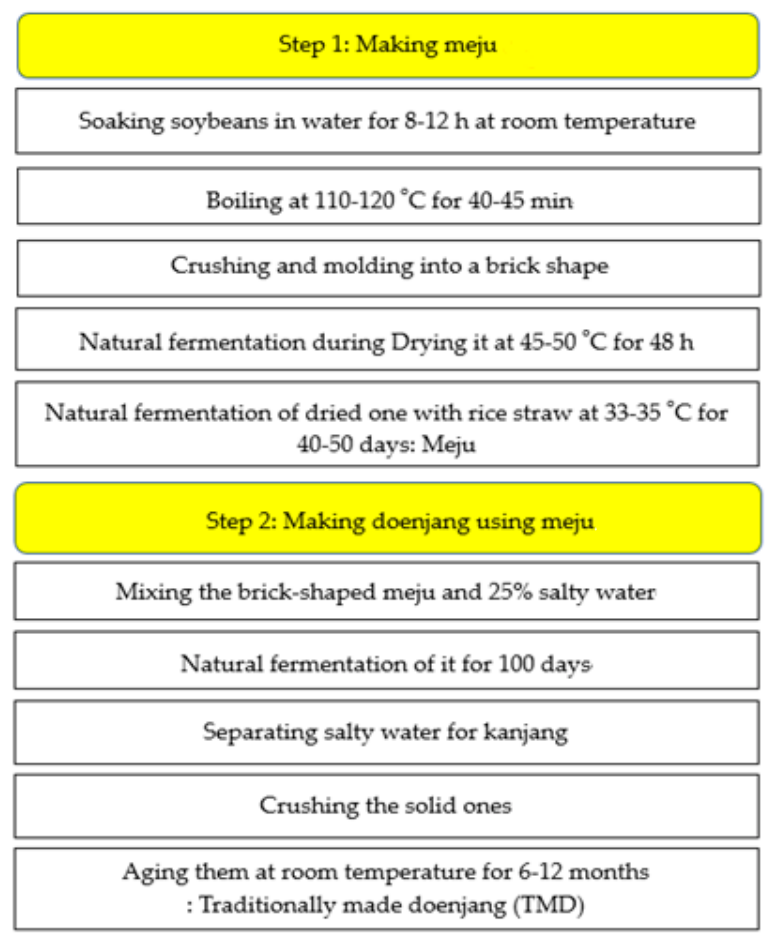
Figure 1. Processing steps of making traditionally made